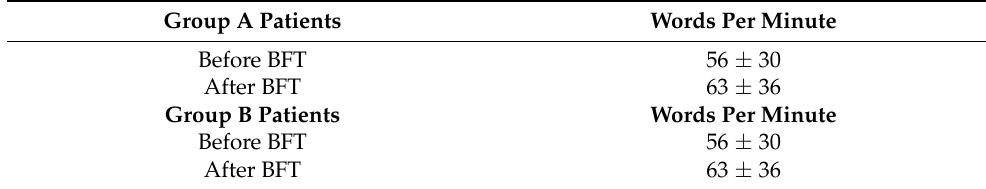
Table 1. Mean reading speeds (wpm) before and after eye movement training in Morales et al. 2019. Group A